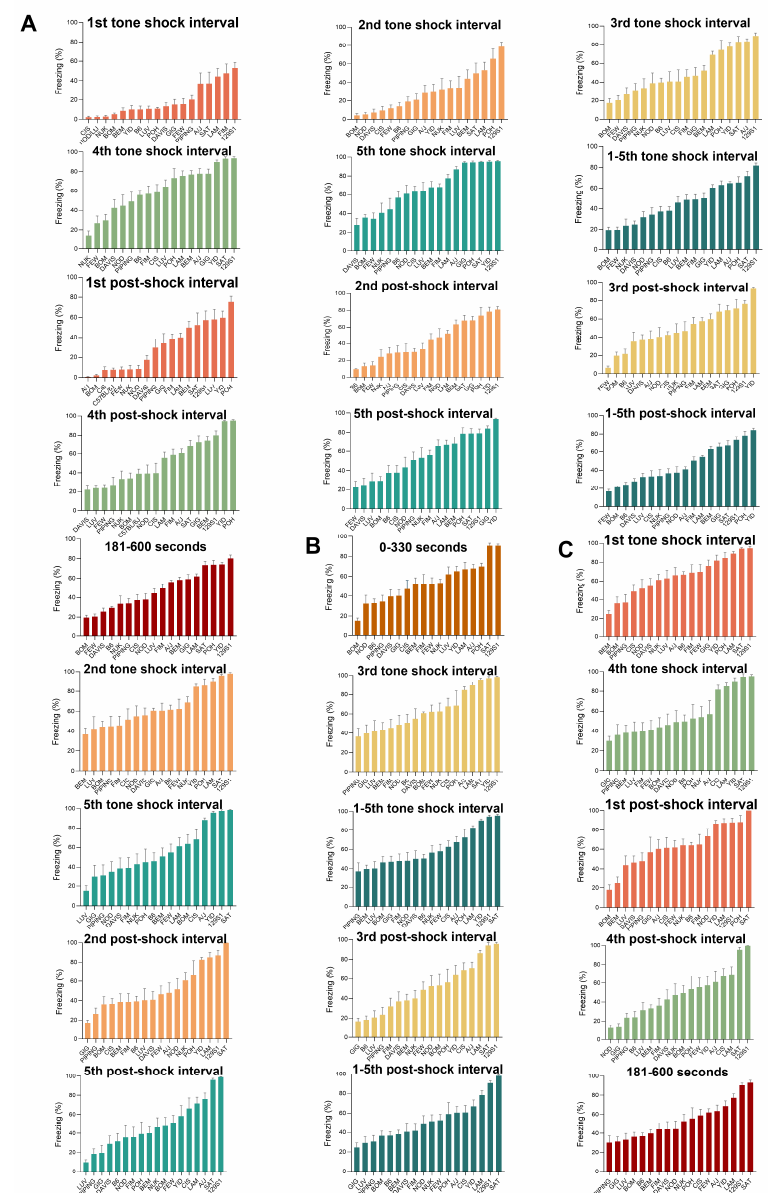
Figure 5. Phenotypic diversity in fear conditioning traits among the CC population. ( A ) 13 parameters used as indices of fear conditioning acquisition: the percentage of time spent freezing during the first, second, third, fourth, fifth tone shock interval, the percentage of time spent freezing during the total five tone intervals on Day 2 for fear conditioning training, the percentage of time spent freezing during the first, second, third, fourth and fifth post-shock interval, the percentage of time spent freezing during the total five post-shock intervals, the percentage of time spent freezing during 181–600 s on Day 2 for fear conditioning training, respectively. ( B ) A parameter used as an index of contextual fear memory: the percentage of time spent freezing during 0–330 s on Day 3 for contextual fear conditioning. ( C ) 13 parameters used as indices of cued fear memory: The percentage of time spent freezing during the first, second, third, fourth, fifth tone shock interval, the percentage of time spent freezing during the total five tone intervals on Day 4 for fear conditioning training, the percentage of time spent freezing during the first, second, third, fourth and fifth post-shock interval, the percentage of time spent freezing during the total five post-shock intervals, the percentage of time spent freezing during 181–600 s on Day 4 for cued fear conditioning, respectively. (Each parameter in ( A – C ) one-way ANOVA test p <